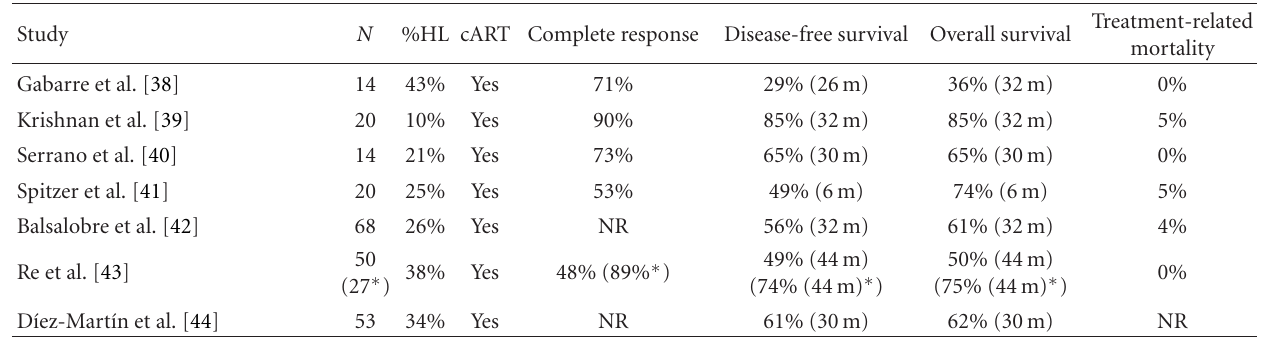
Table 2: Studies of high-dose chemotherapy with autologous stem cell transplantation in relapsed HIV-associated lymphomas.